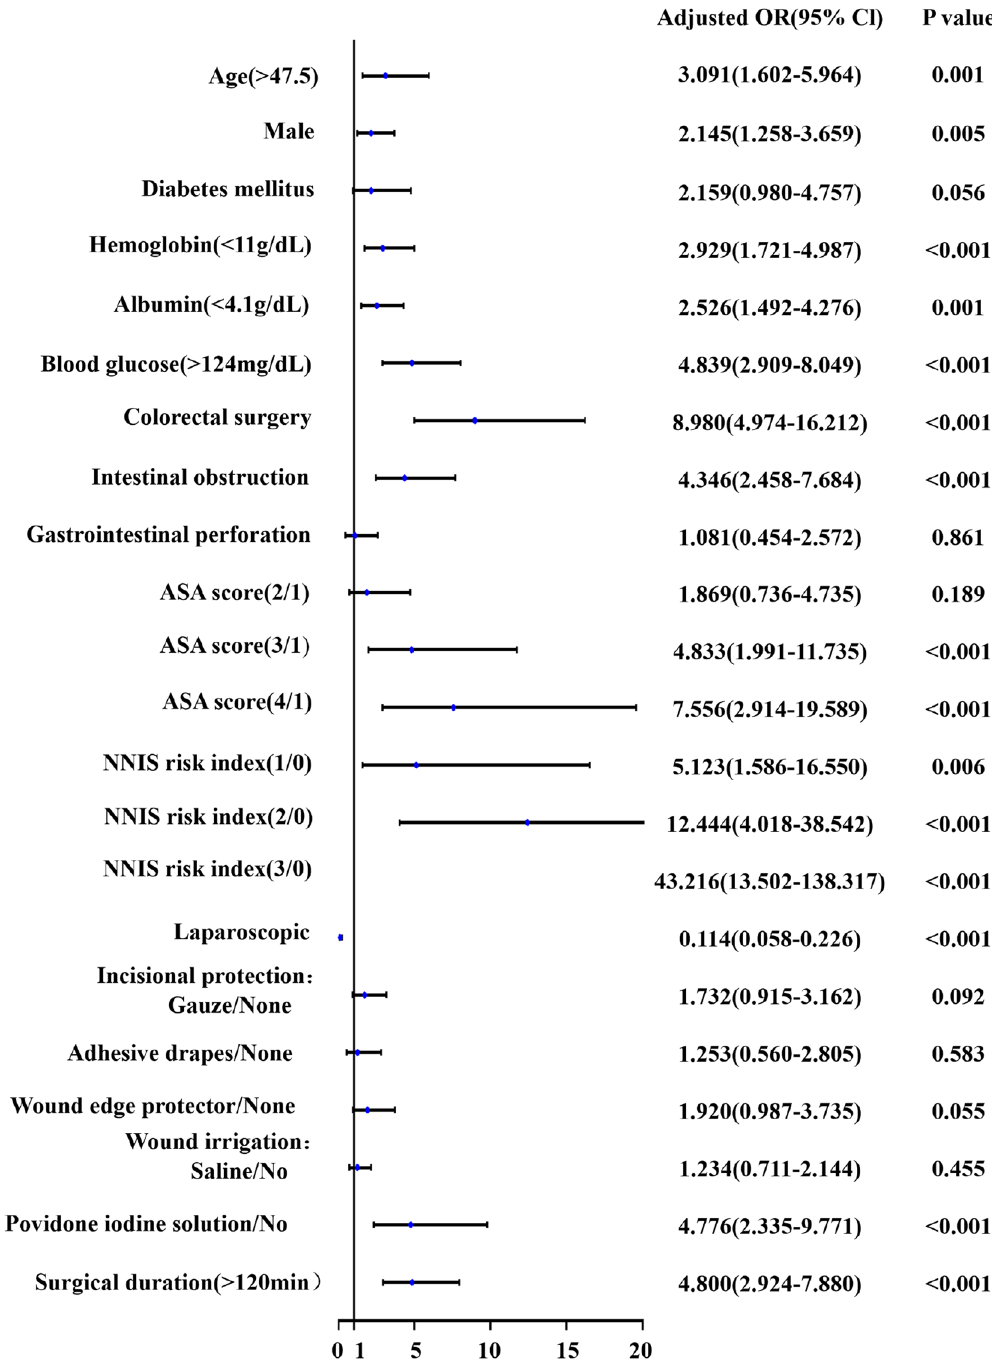
Figure 2. Results of univariate logistic regression